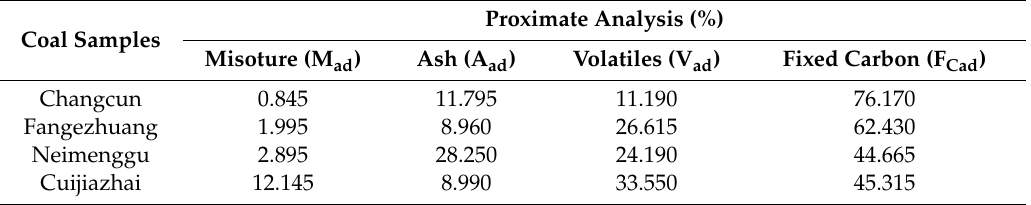
Table 1. Proximate analysis of coal